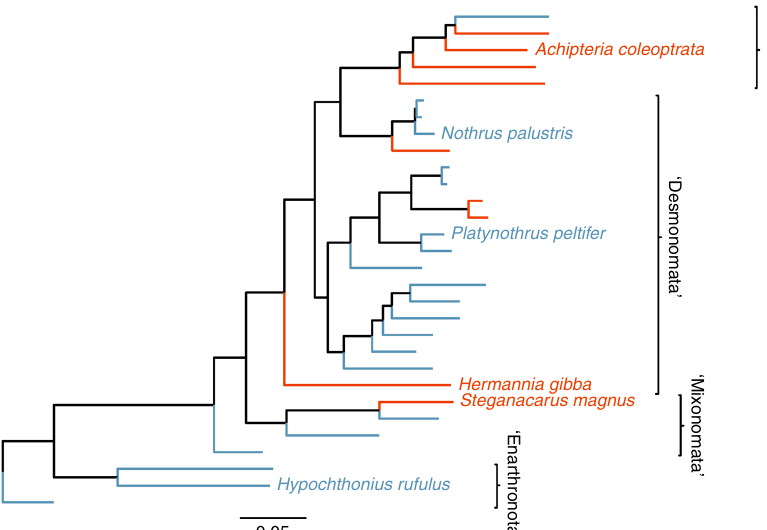
Fig. 1 Phylogenetic tree of 30 oribatid mite species analysed in this study. The tree is based on partial sequences of 18S rDNA, ef1 α and hsp82 (see ‘ Methods ’ ). The taxon sampling covers asexual (blue) and sexual (red) species from four out of six major groups of oribatid mites (brackets). Species used for transcriptome-wide analyses are indicated with full name, remaining species names are listed from top to bottom in Supplementary Table